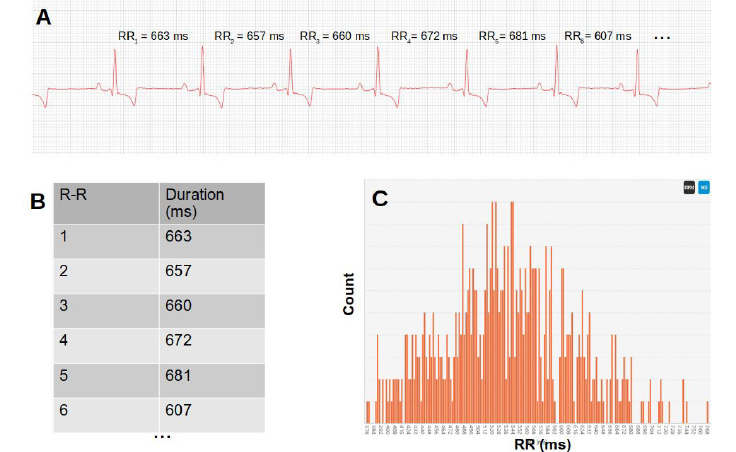
Figure 1. ECG tracing ( A ) showing consecutives R-R intervals enlisted in a table ( B ) that in turn is used to plot the interval histogram or density plot ( C ). Through this graph it is possible to visually inspect the HRV. Most time domain methods are derived from the statistical properties of the time series or from geometrical properties of the density